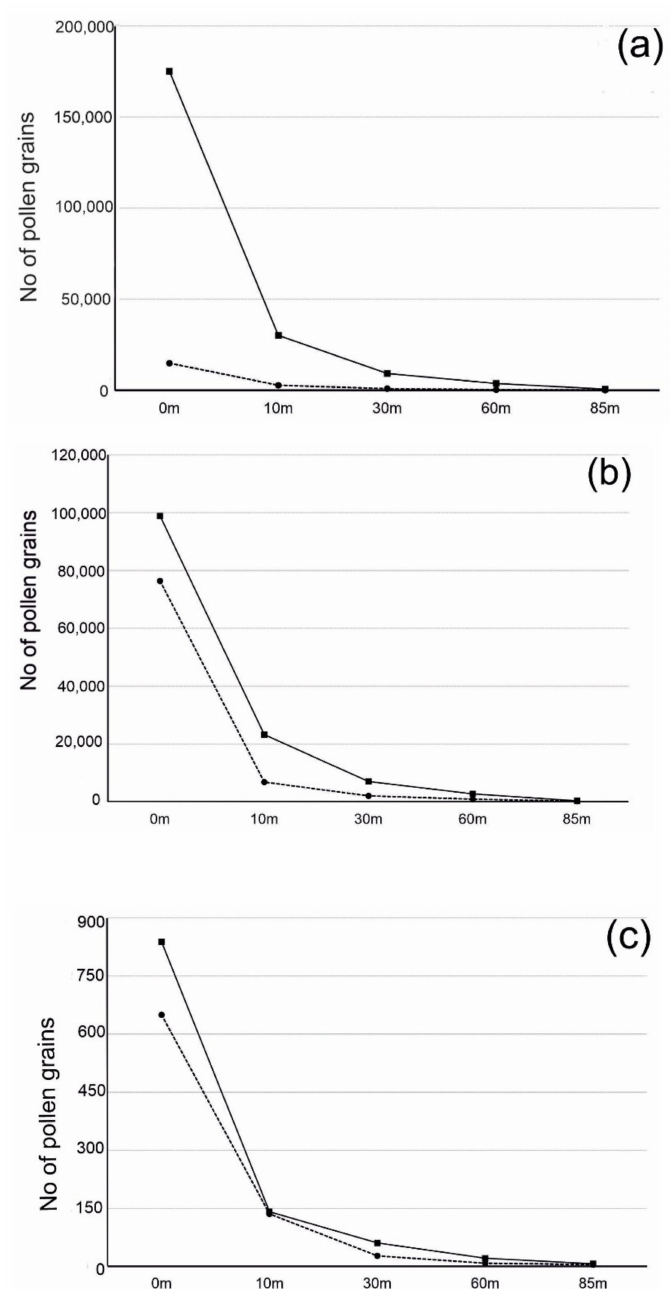
Figure 3. Relationship between the number of transgenic triticale pollen grains and the distance in the first year (solid line) and second year of study (dotted line)—( a ), and the relationship between the number of transgenic triticale pollen grains and the experiment design in the first ( b ) and the second year ( c ). In both graphs: solid line—spatial isolation variant, dotted line - border rows variant. For experiment design description see Figure